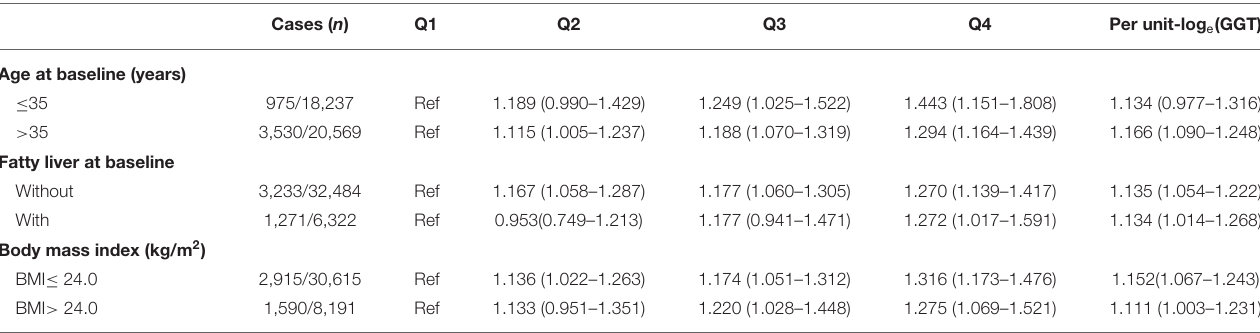
FIGURE 2 | Curve-fitting between serum gamma-glutamyltransferase (GGT) level and incidence of hypertension in (A) males and (B) females. TABLE 3 | Risk of incident hypertension according to baseline serum gamma-glutamyltransferase quartiles stratified by age, fatty liver, and body mass